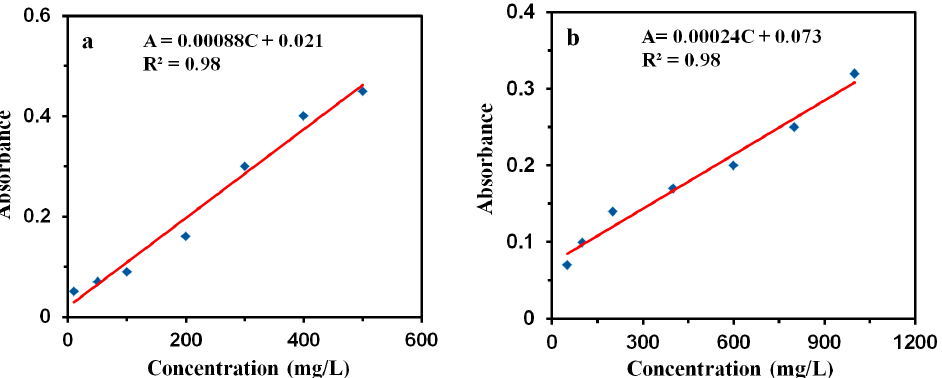
Figure 1. Standard working curves of toluene ( a ) and ethyl acetate solution ( b ). (The blue squares represent testing results, and the red lines represent fitting results).